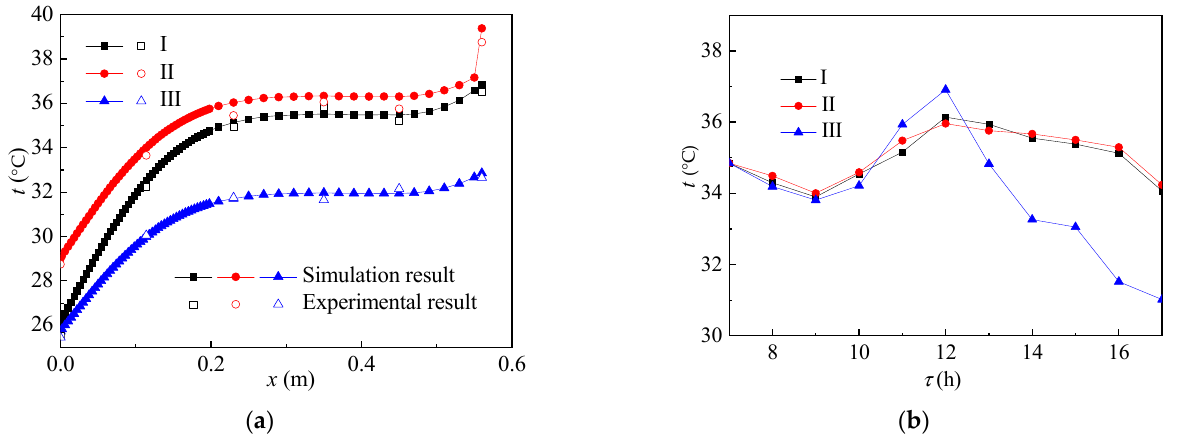
Figure 5. Temperature distribution with increase in ( a ) height and ( b ) time in the reactor.